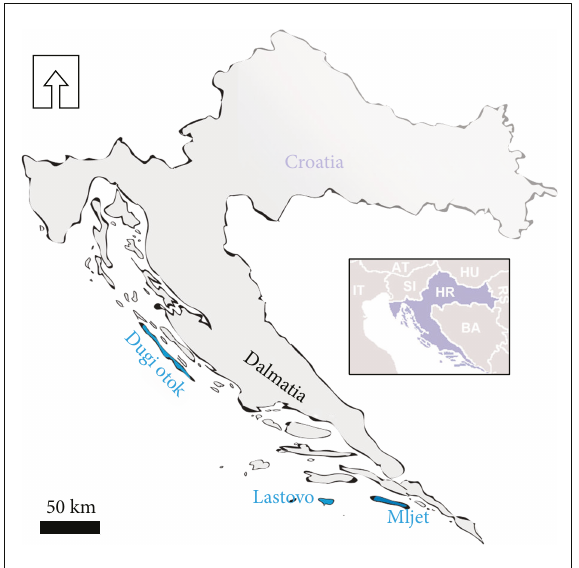
Figure 1: Position of Croatia on the Adriatic coast of SE Europe and the island of Mljet in S Dalmatia region (AT: Austria; BA: Bosnia and Herzegovina; HR: Croatia; HU: Hungary; IT: Italy; RS: Serbia; SI: